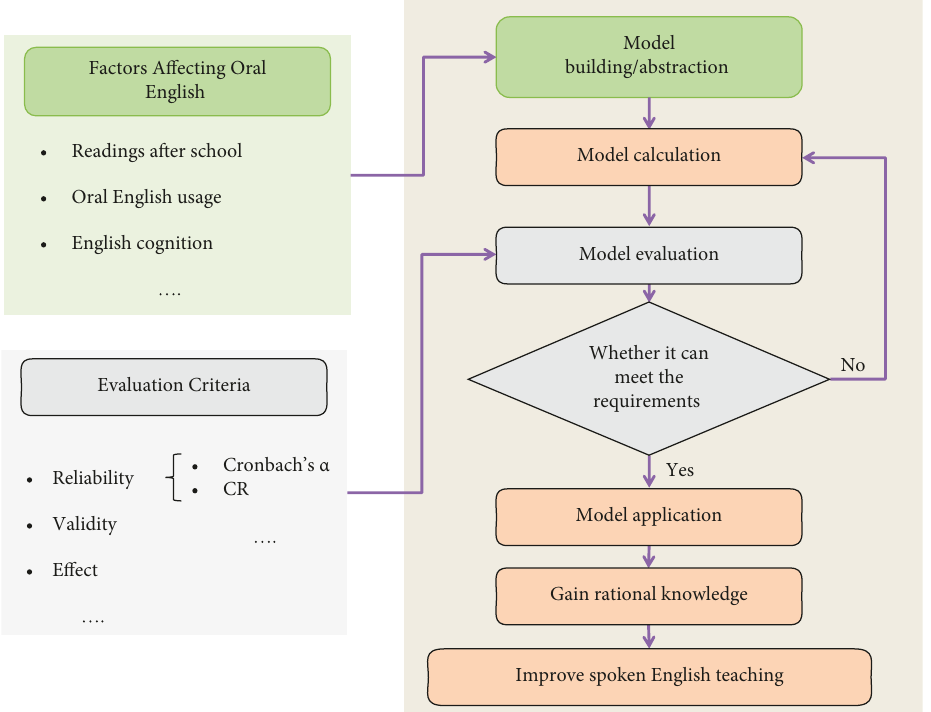
Figure 4: Analysis framework of oral English based on